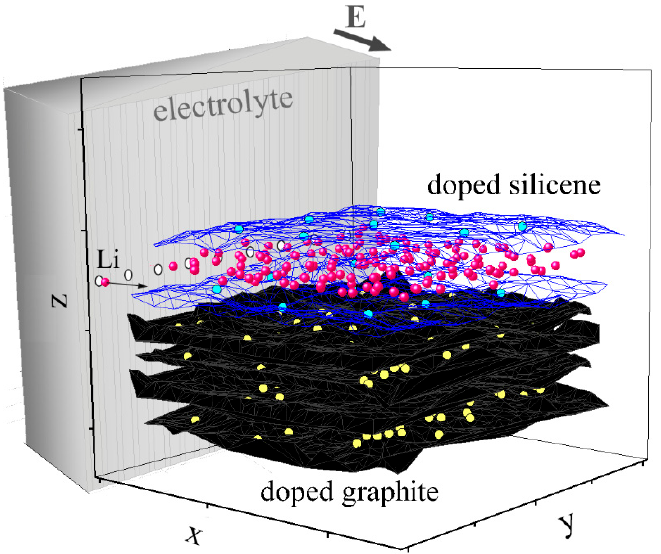
Figure 2. Schematic diagram of the doped system (“silicene channel on a graphite substrate”), in which the channel was filled with lithium. Lithium ions entered the channel through a solid electrolyte. The walls of the channel are translucent, lithium atoms are shown as red circles, phosphorus atoms are represented by blue circles, and nitrogen atoms are shown as yellow circles.